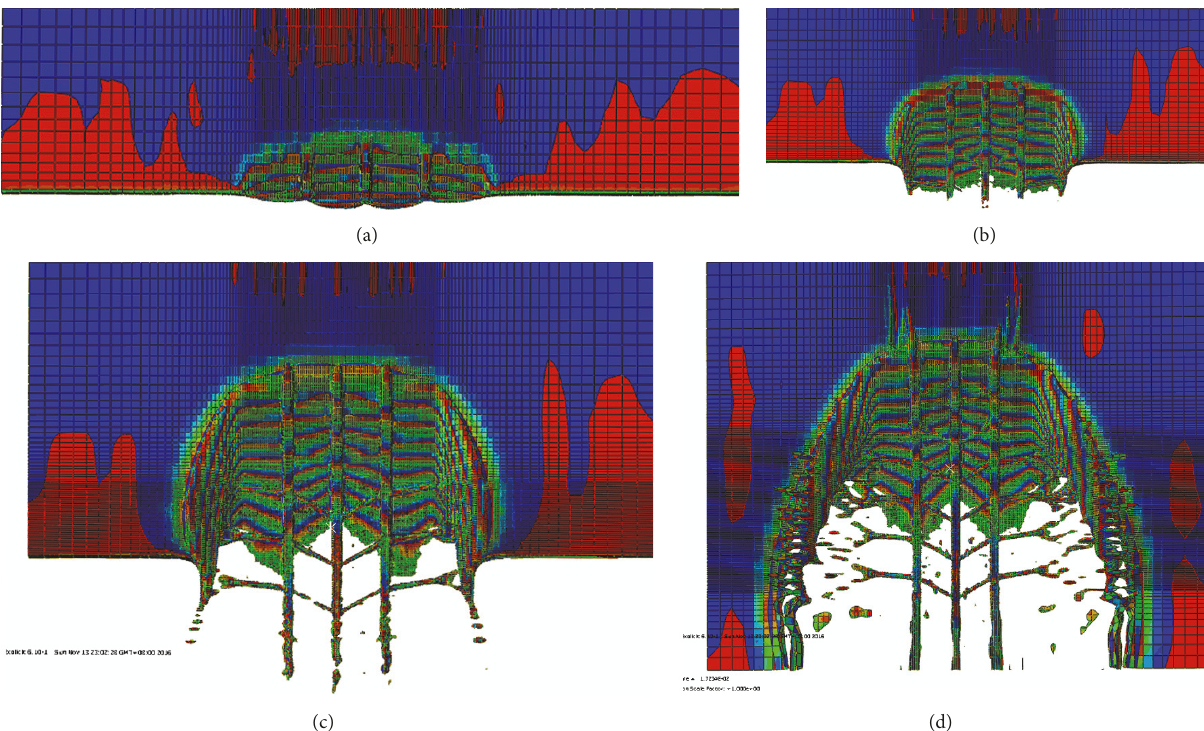
Figure 11: Water flowing in the tire pattern groove: (a) time = 7.00511s; (b) time = 7.00681 s; (c) time = 7.00931; (d) time = 7.01611.